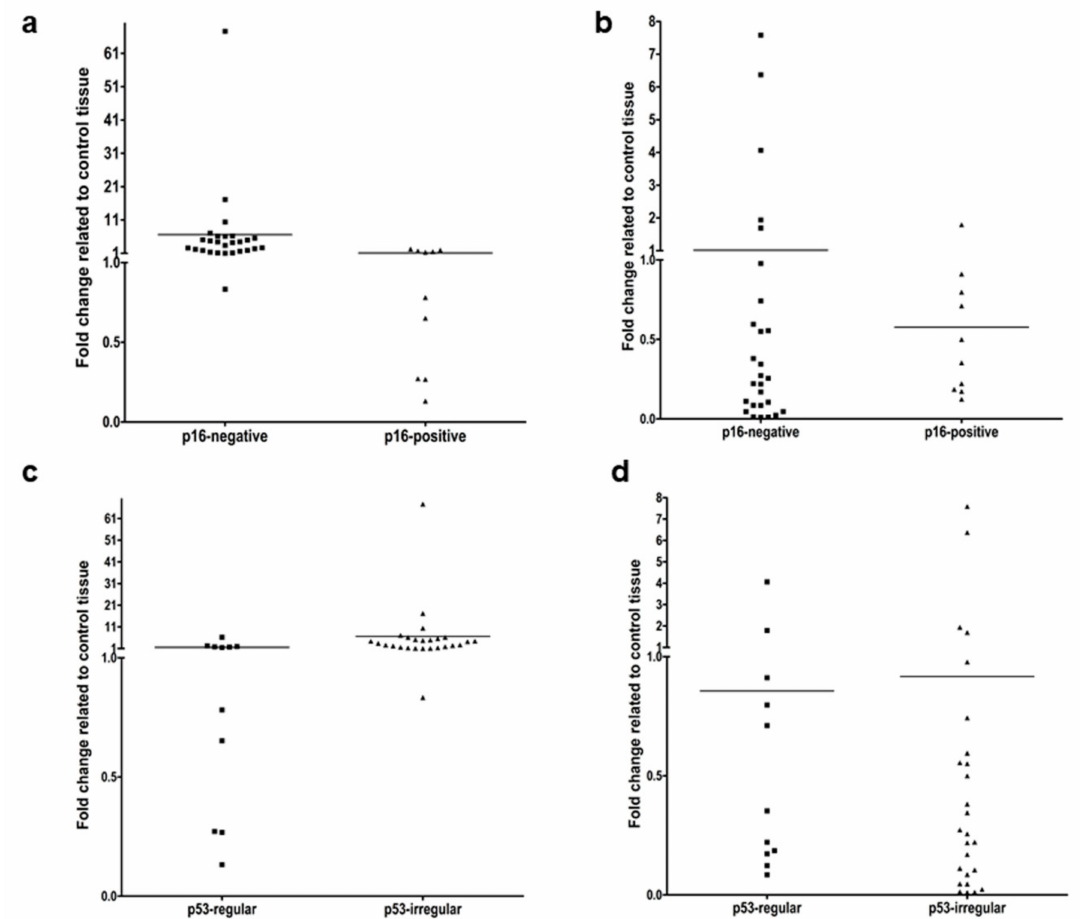
Figure 3. Comparison of relative quantification of Slug ( a , c ) and KLF4 ( b , d ) gene expression in p16-positive and negative ( a , b ) HNSCC, as well as in HNSCC with regular and irregular p53 gene expression ( c , d ). Ten HPV-positive and 27 HPV- negative HNSCC samples were used for real-time PCR analysis. On the Y -axis the fold change difference to the mean reference value of normal mucosa is presented. None of the compared sample sets showed normal distribution. The median of Slug gene expression in p16-negative HNSCC samples was significantly higher ( p = 5 × 10 − 4 ) than in p16-positive samples ( a ). In contrast, KLF4 gene expression was not significantly different in p16-positive or negative cases ( b ). Eleven HNSCC samples were available with regular (wild type) and 26 with irregular (mainly mutated) p53 gene background. The median of Slug gene expression in HNSCC samples with irregular p53 was significantly higher ( p = 5.5 × 10 − 3 ) than in samples with regular p53 ( c ). In contrast, KLF4 gene expression was not significantly different in cases with regular or irregular p53 ( d ). All datasets were not normal distributed, and Mann-Whitney-test median comparison was